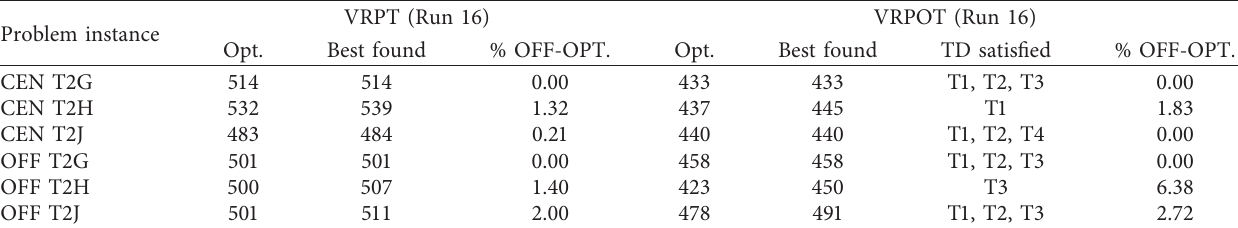
Table 4: Solution comparison for Run 16 of set T instance.